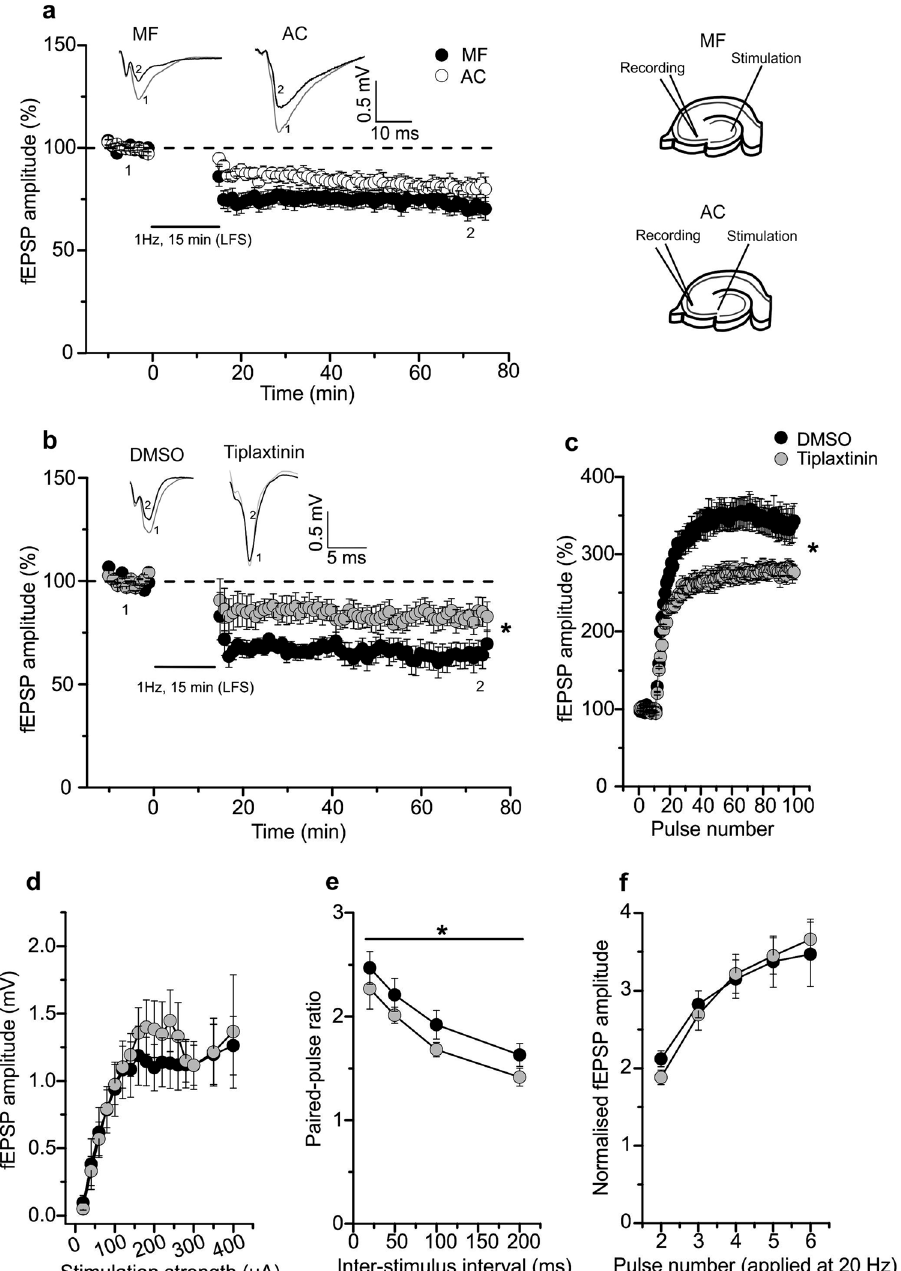
Figure 1. Mossy fiber (MF)-CA3 synapses show BDNF-dependent LTD, frequency facilitation and paired-pulse facilitation. (a) LTD magnitude at MF-CA3 synapses induced by low frequency stimulation (LFS, 900 pulses, 1 Hz) was similar to AC synapses (filled circle: MF (n = 16/N = 12); open circle: AC fibers (n = 10/N = 7)). Representative averaged original responses are shown for both, MF and AC fiber LTD. In the graph, “1” depicts mean fEPSP amplitudes of first 10 min of baseline and “2” indicates mean fEPSP amplitudes between 55 and 60 min after induction of LTD. ( b ) LTD at MF-CA3 synapses is significantly impaired in the presence of tiplaxtinin (150 µM; an inhibitor of plasminogen activator inhibitor-1) in comparison to DMSO treated control (filled circle: DMSO (n = 8/N = 6); filled gray circle:Tiplaxtinin (n = 8/N = 6). The inset shows representative averaged original fEPSP responses. For MF-LTD in DMSO and in the presence of tiplaxtinin, “1” depicts mean fEPSP amplitudes of first 10 min of baseline and “2” depict mean fEPSP amplitudes between 55 and 60 min after induction of LTD. ( c ) and ( e ) Tiplaxtinin treated slices showed significantly decreased frequency facilitation ( c ) and paired-pulse facilitation ( e ) at MF-CA3 synapses (filled circle: DMSO (n = 9/N = 7); filled gray circle:Tiplaxtinin (n = 9/N = 7). ( d ) and ( f ) Input–output curve of basal synaptic responses (c; filled circle: DMSO (n = 7/N = 5); filled gray circle: Tiplaxtinin (n = 9/N = 7)) and train facilitation (e; filled circle: DMSO (n = 9/N = 7); filled gray circle: Tiplaxtinin (n = 9/N = 7)) at MF synapses exhibited no change in presence of tiplaxtinin compared to DMSO control. Data shown as mean ± SEM. Scale bars are exhibited in the inset. *p < 0.05 (two-tailed Student’s t-test, Mann–Whitney U-test or